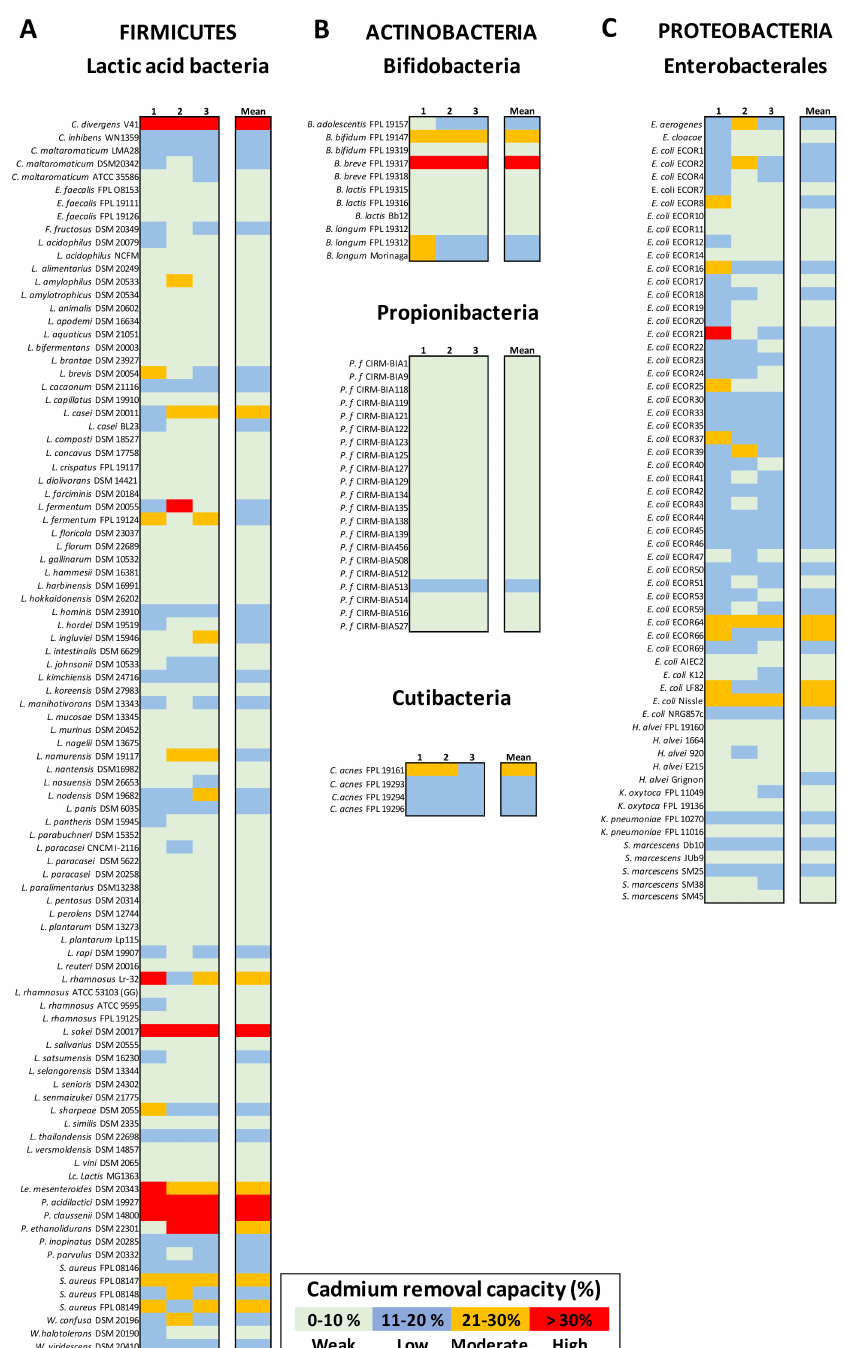
Figure 3. The Cd(II) removal capacity of bacteria from distinct taxonomic phyla. Panel ( A ): LAB. Panel ( B ): Actinobacteria, comprising bifidobacteria, propionibacteria, and cutibacteria. Panel ( C ): Proteobacteria, as Enterobacterales. Metal removal capacity was defined as the mean ± SD percentage of the initial quantity of metal in solution, in triplicate experiments. Here, the Cd removal capacity is color-coded as weak (0 to 10%: pale green), low (11 to 20%: blue), moderate (21 to 30%: orange), or high (over 30%: